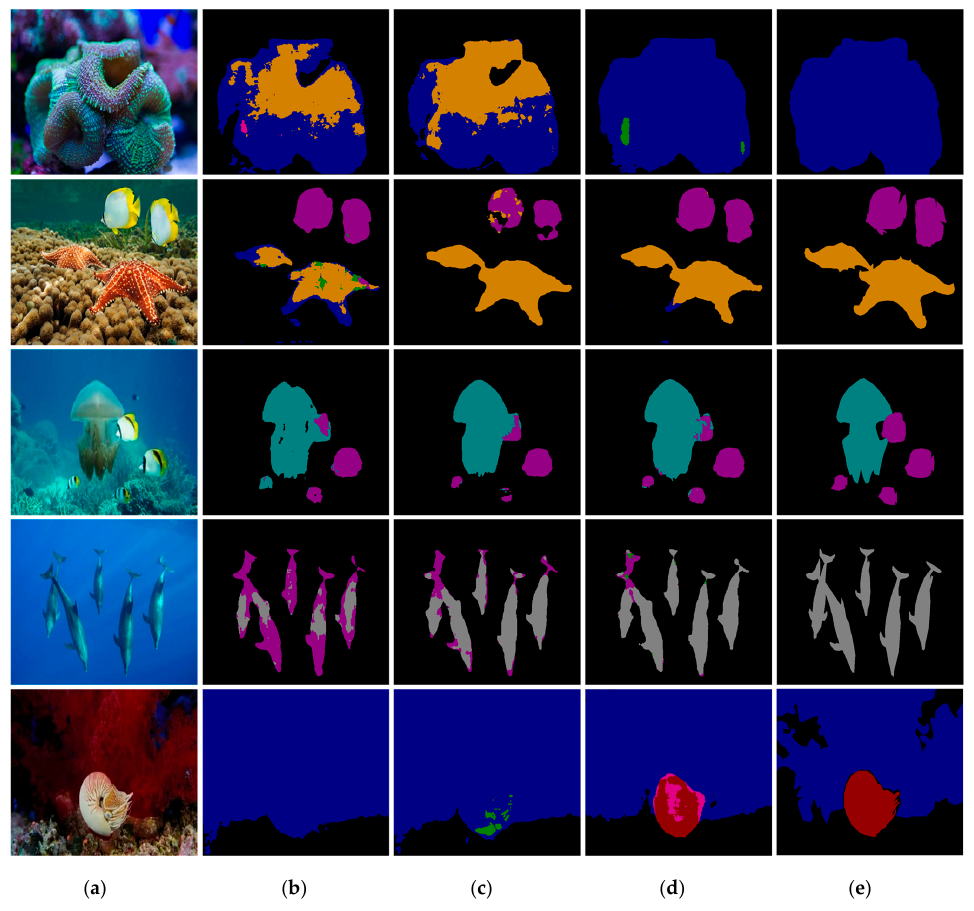
Figure 8. Experimental results and comparison with other methods. ( a ) Original image. ( b ) PSPNet. ( c ) DeepLabv3+. ( d ) Our method. ( e ) Ground truth.